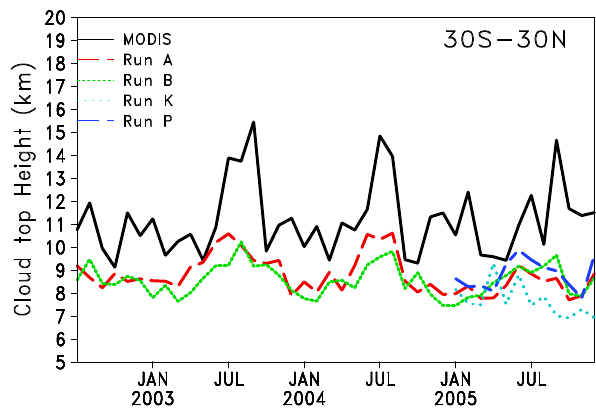
Fig. 9. Time series of monthly mean maximum daily cloud top height (km) for 2002(cid:150)2005 averaged between 30 (cid:14) S(cid:150)30 (cid:14) N from MODIS and model runs (cid:147)A E40(cid:148), (cid:147)B EI(cid:148),(cid:147)K L31(cid:148) and (cid:147)P det(cid:148).